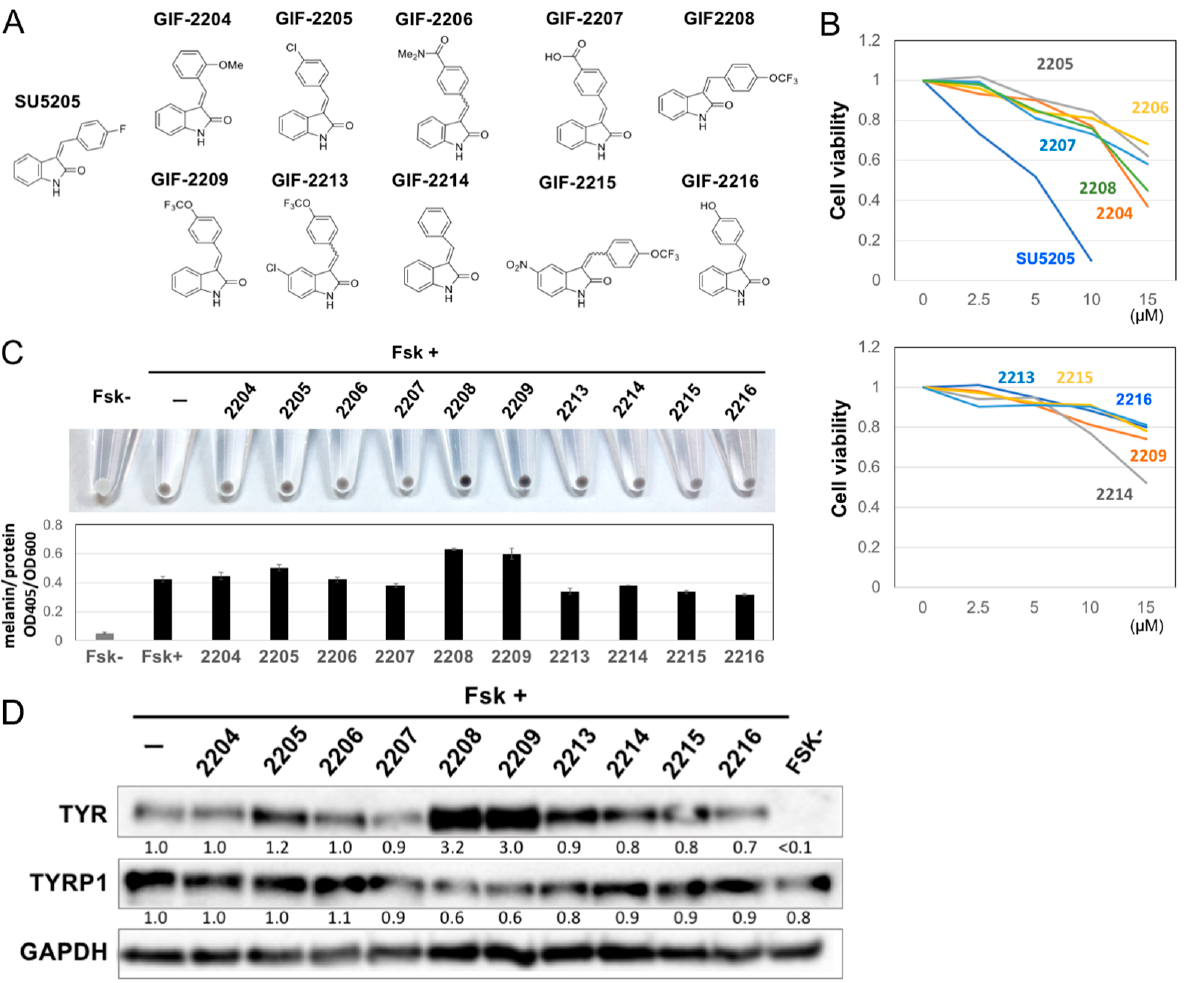
Figure 1. ( A ) Structures of oxindole derivatives (GIF compounds). ( B ) B16F10 cells were treated with compounds for 48 h. Cell viability was measured with WST-8. Means of duplicated experiments are shown. ( C ) B16F10 cells were treated with 5 μ M of oxindole derivatives in the presence of 20 μ M forskolin (Fsk) for 48 h. Melanin production in the B16F10 cells was visually evaluated by photo, and the melanin content was measured after alkaline lysis and normalized to protein content. n = 3. ( D ) Protein expression for TYR, TYRP-1, and GAPDH in B16F10 cells that had been treated as in ( C ) were examined by western blotting. The images are representative of triplicated experiments. The